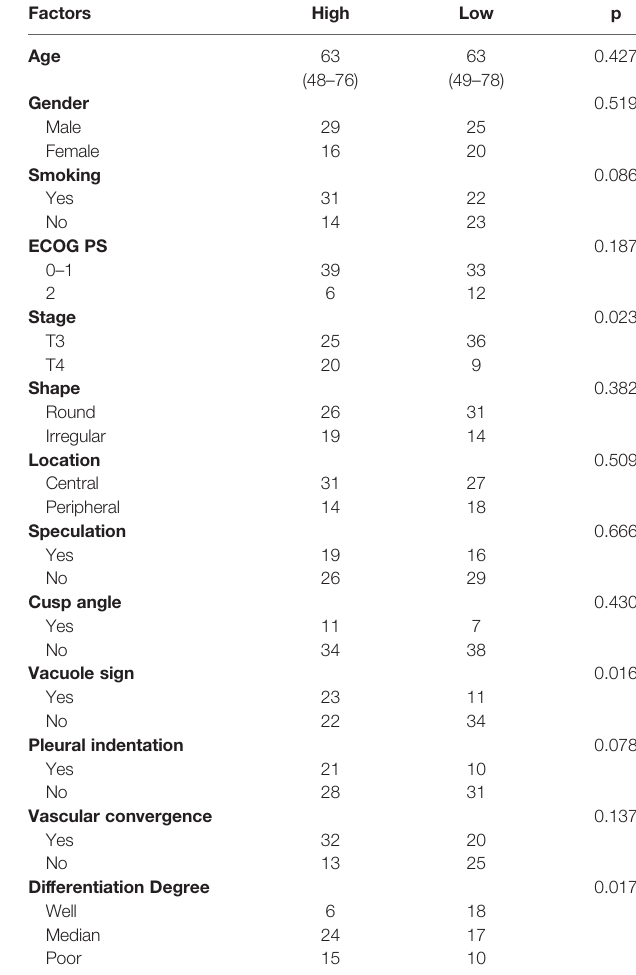
TABLE 2 | The correlation of PD-L1 expression level and clinicopathological with CT morphological factors. Factors